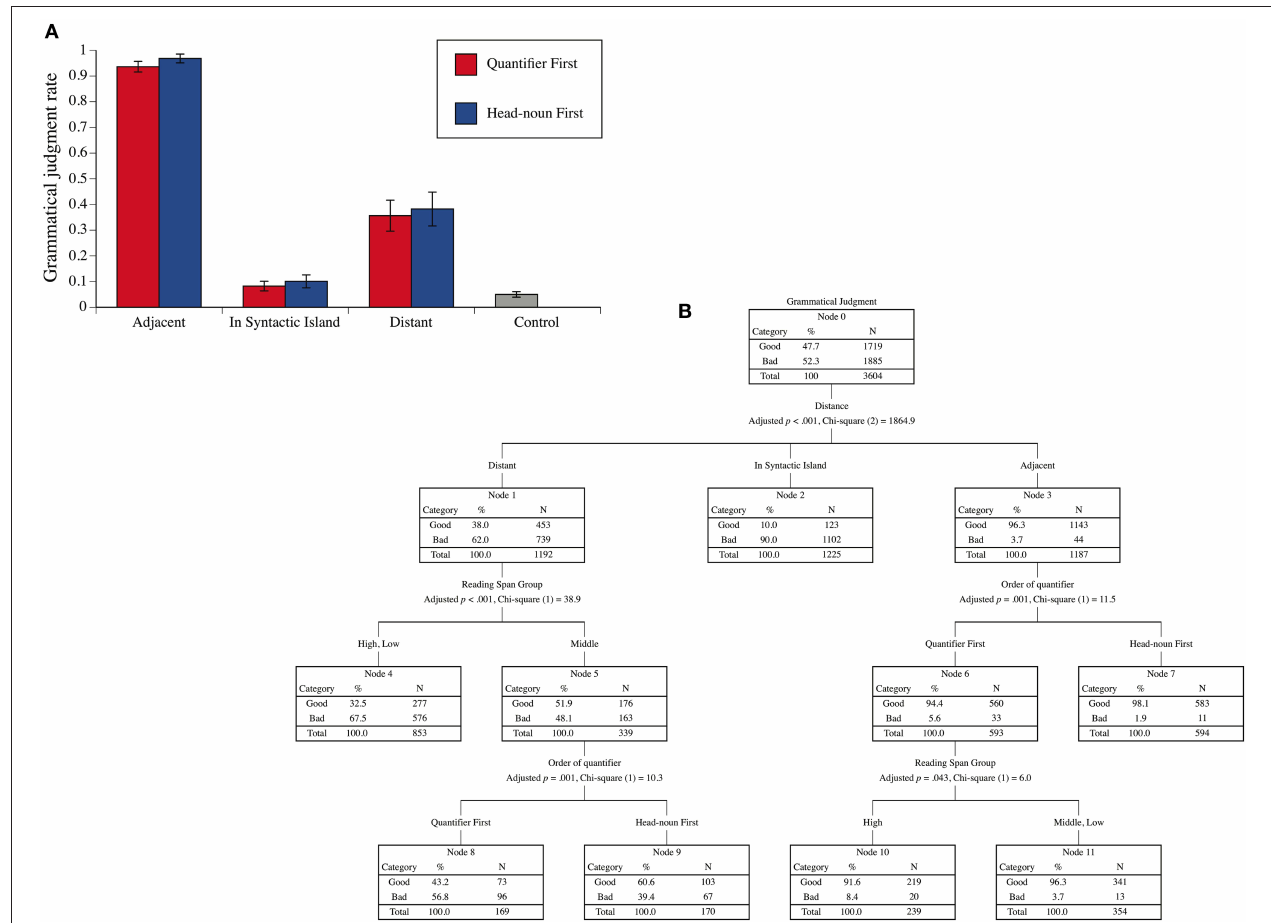
FIGURE 1 | (A) Mean “grammaticality” judgment rates of the experimental sentences for the two precedence relationships between a quantifier and its head noun (Quantifier First and Head-noun First) and for the three distances between the two (Adjacent, In Syntactic Island, and Distant) and the mean rate of ungrammatical control sentences. The error bars indicate the standard errors. (B) A decision tree for the grammatical judgments with the reading span group, the two precedence relationships between a quantifier and its head noun, the three distances between the two, and the two connective particles at the subordinate verbs ( -tsutsu and -nagara ) as independent